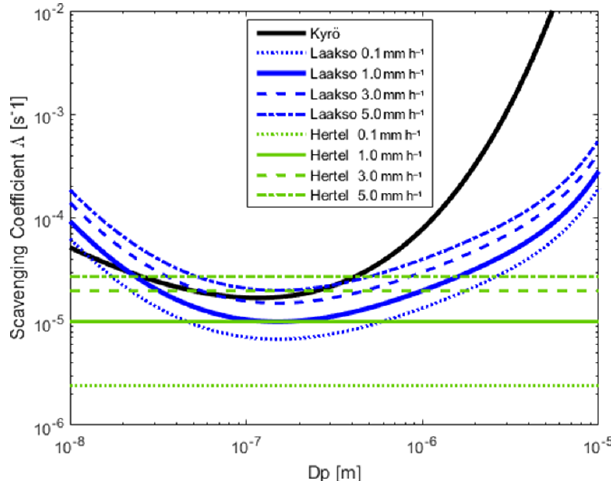
Figure 2. Below-cloud scavenging coefficients as a function of aerosol size. Shown are the new parameterizations of Laakso et al. (2003) (blue lines) for rain and Kyrö et al. (2009) (black line) for snow, and the old parameterization of Hertel et al. (1995) used in previous FLEXPART versions with the parameters A = 1 e − 5 and B = 0 . 62 (green). Values are shown for four different precipitation intensities: 0.1 (dotted lines), 1 (solid lines), 3 (dashed lines) and 5mmh − 1 (stippled